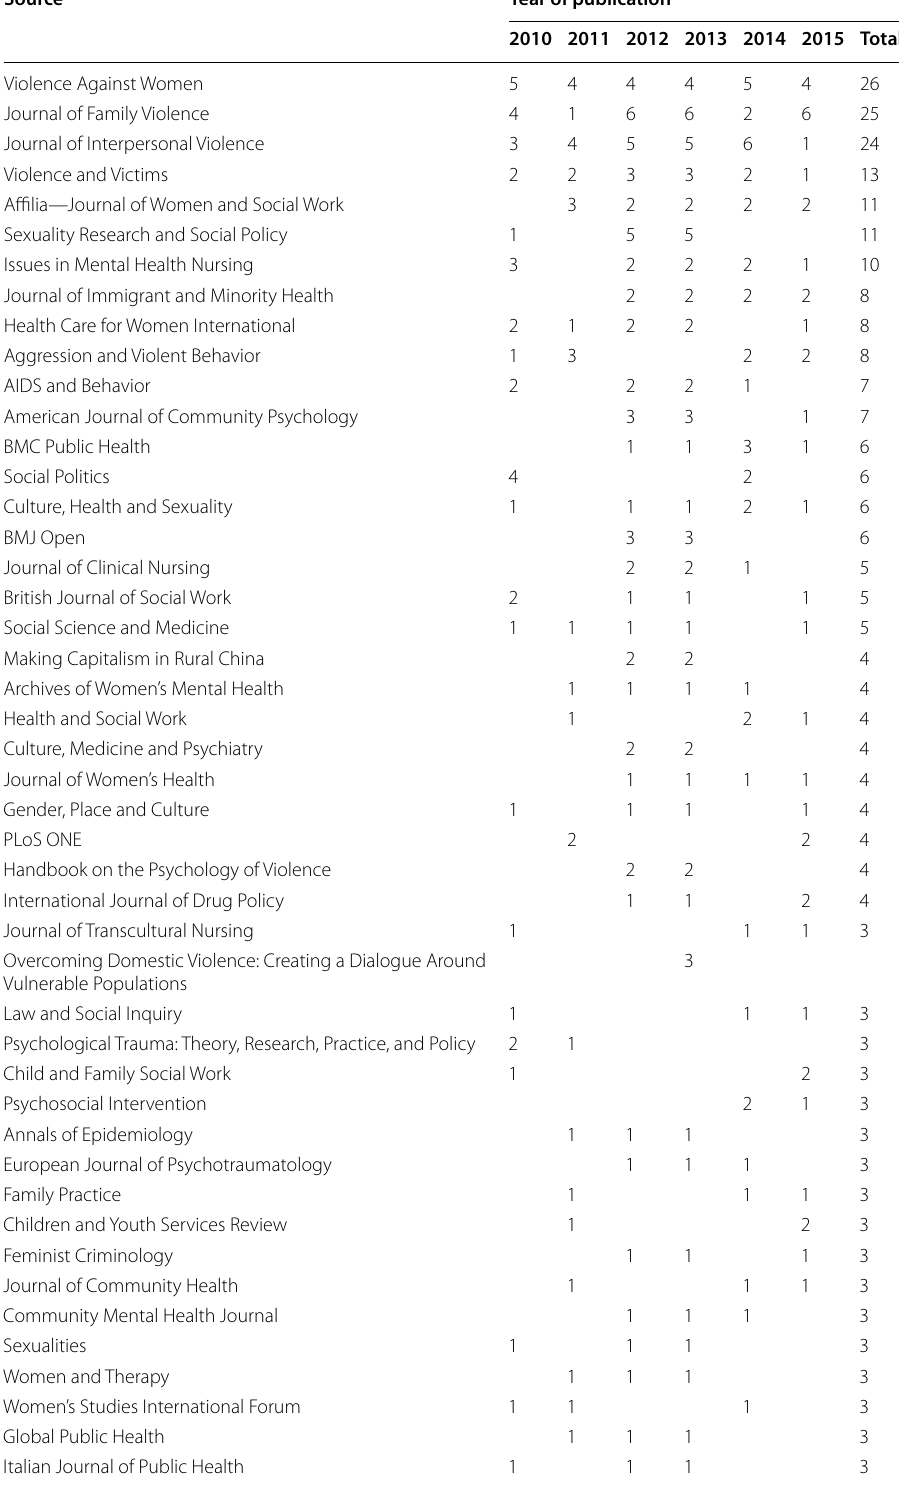
Table 2 Total number of documents per year by